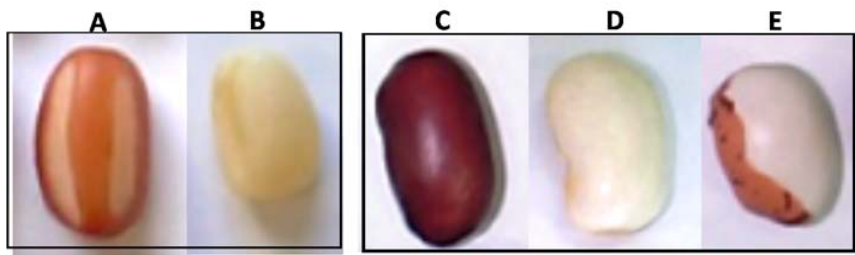
Figure 1. Photographs of partially peeled adzuki bean ( A ), completely peeled adzuki bean ( B ), kintoki kidney bean ( C ), white kidney bean ( D ), and toramame kidney bean ( E